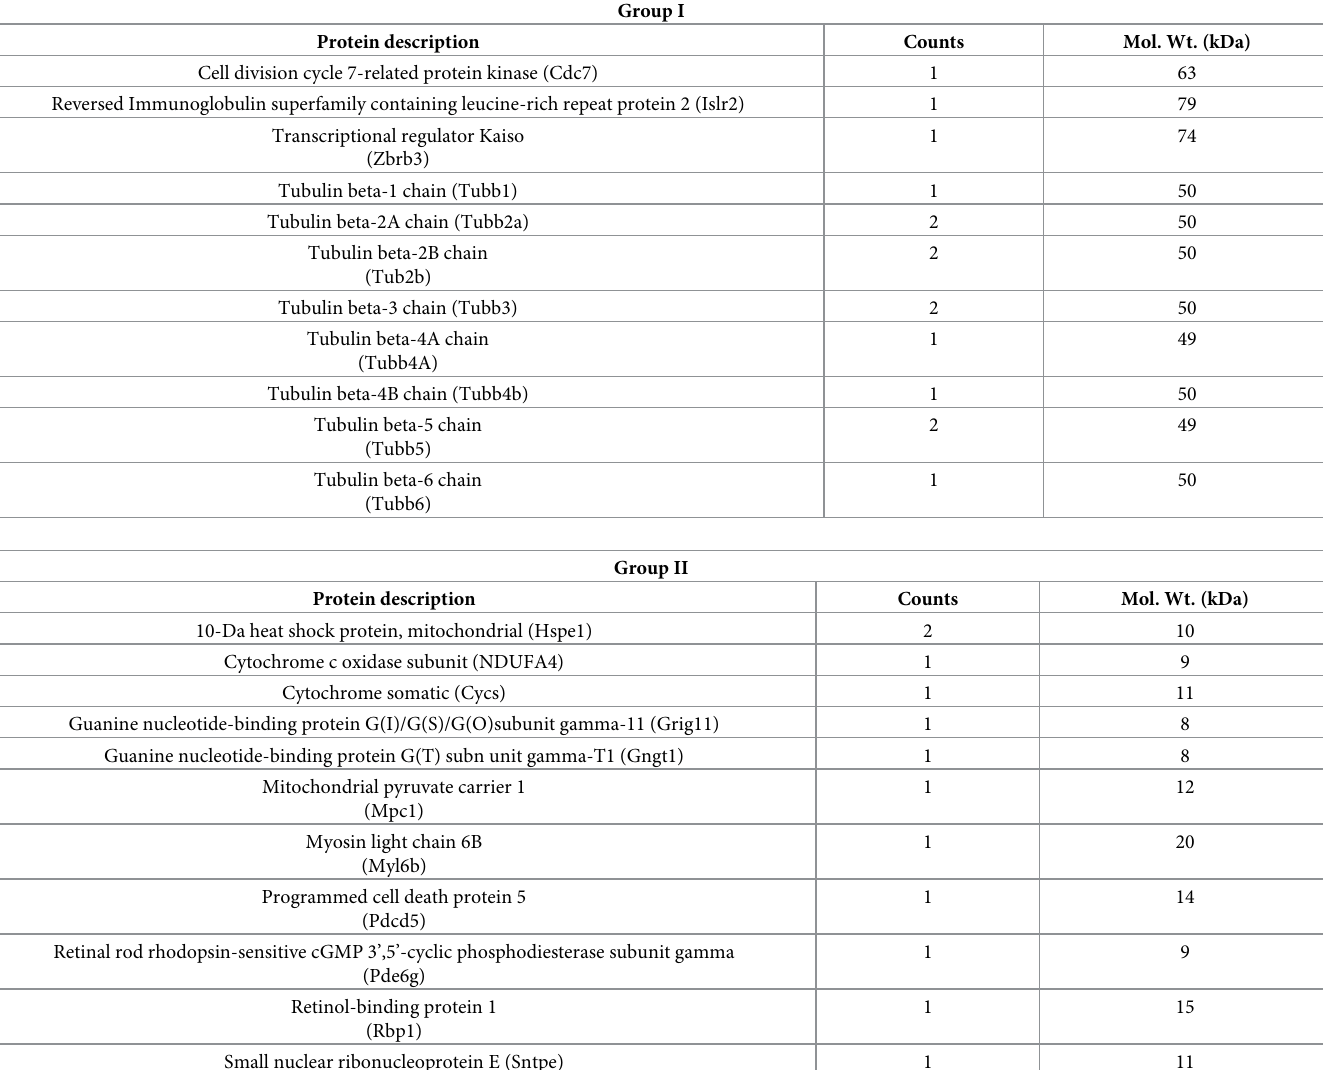
Table 2. Mass spectrometric identification of protein fragments present in the insoluble fraction of β A3 cKO lenses but not in WT and HET lenses following centri- fugation at 800